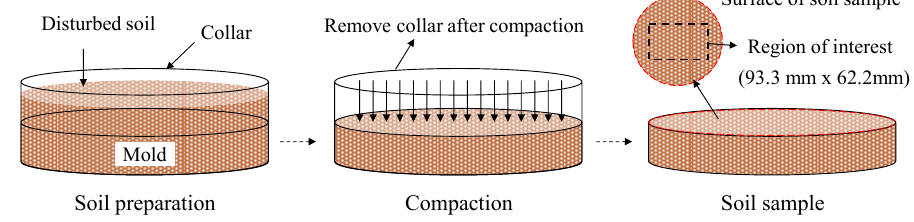
Figure 1. Soil sample preparation process for digital image acquisition of soil surface layer. Digital images were taken under controlled lighting. The correlated color temper- ature (CCT) measured at the soil sample location was 6400 K. The focal length of the digital camera (Canon EOS 100d) was fixed at 35 mm. The size of the digital image was 5184 × 3456 pixels. The photograph was taken in the vertical direction of the soil sample, and the distance between the soil surface and the image sensor of the camera was 240